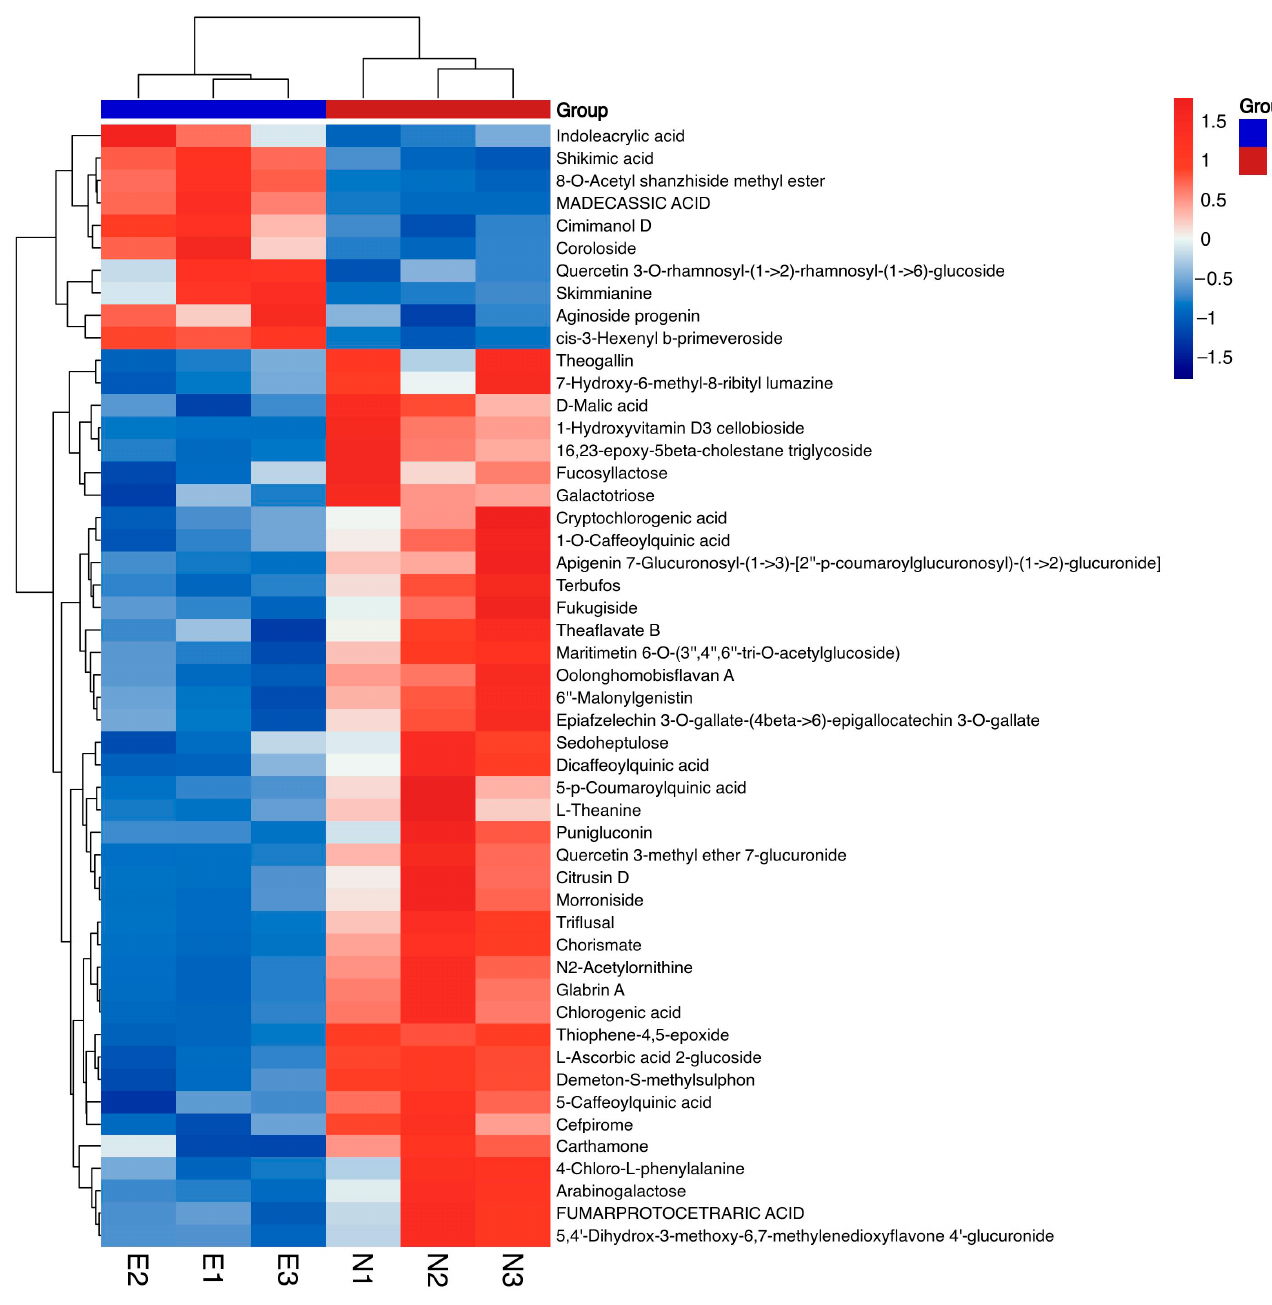
Figure 8. The hierarchical clustering of the top 50 differentially abundant metabolites based on both the positive ion modes and negative ion modes based on LC-MS in the healthy leaves and damaged leaves of E. onukii . The data were log2 transformed, and similarity assessment for clustering was based on the Euclidean distance coefficient and complete clustering algorithm. Columns and rows represent individual metabolites and different samples,